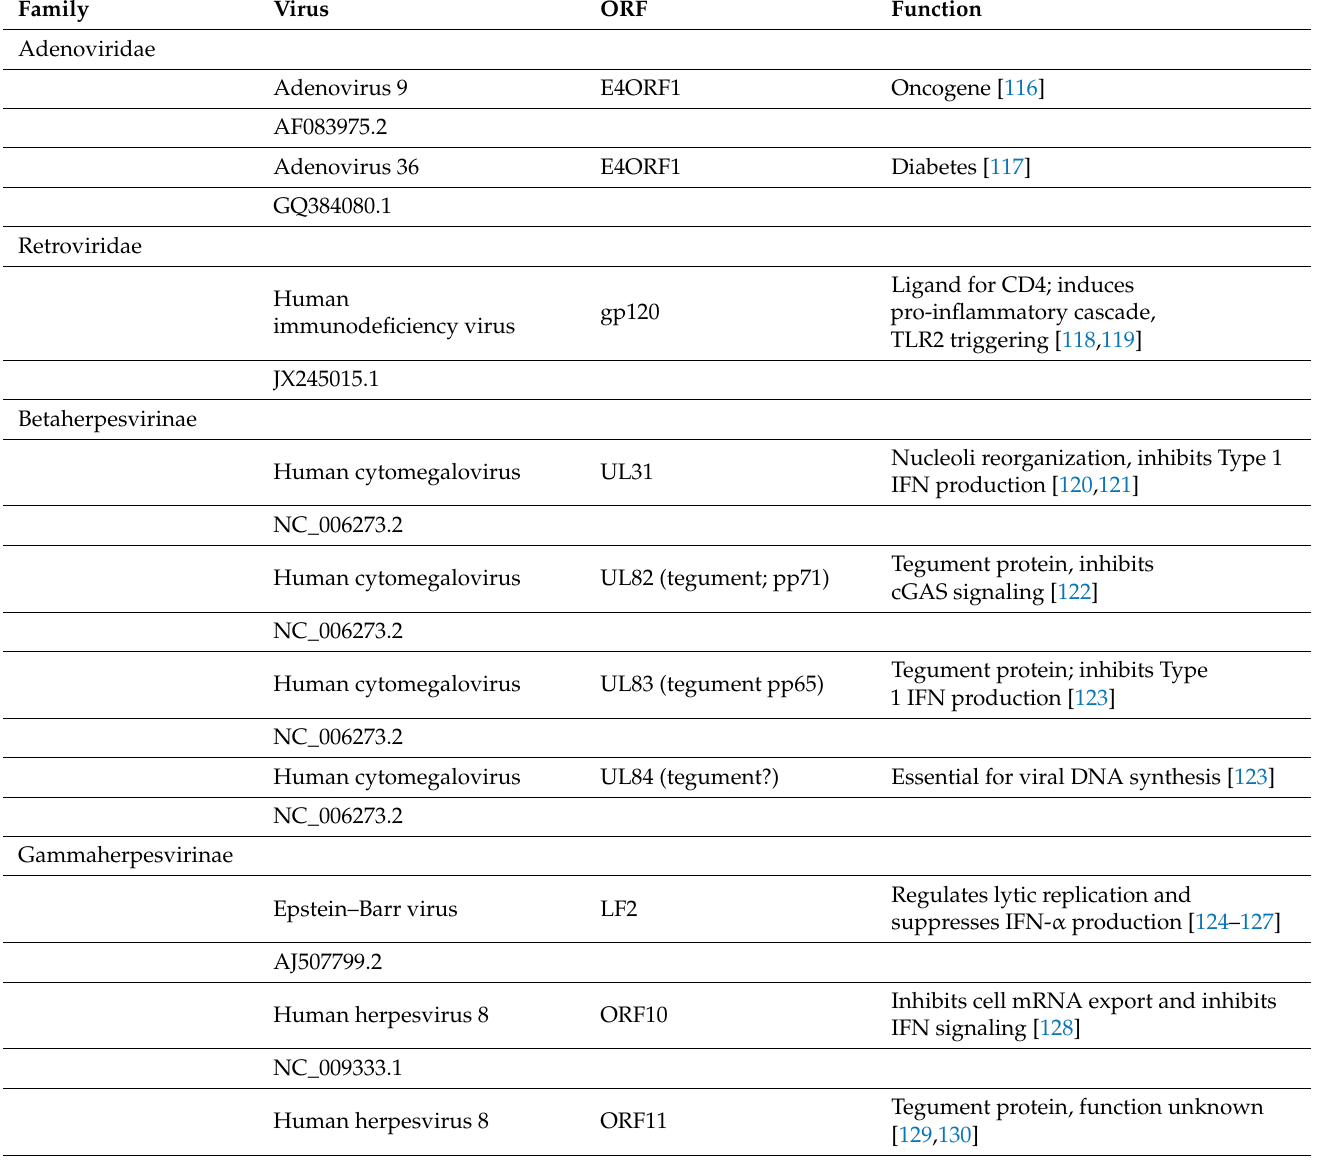
Table 3. dUTPase sequences conserved in other gene